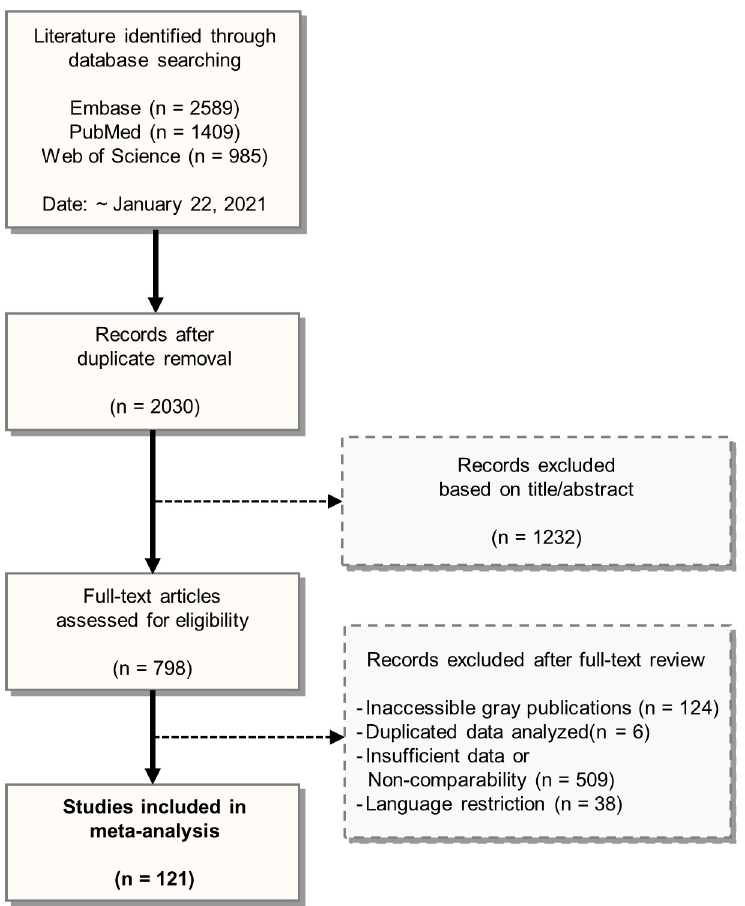
Fig 1. PRISMA flowchart for study selection. Preferred Reporting Items for Systematic Reviews and Meta-Analyses (PRISMA) flow diagram of literature search and study selection.